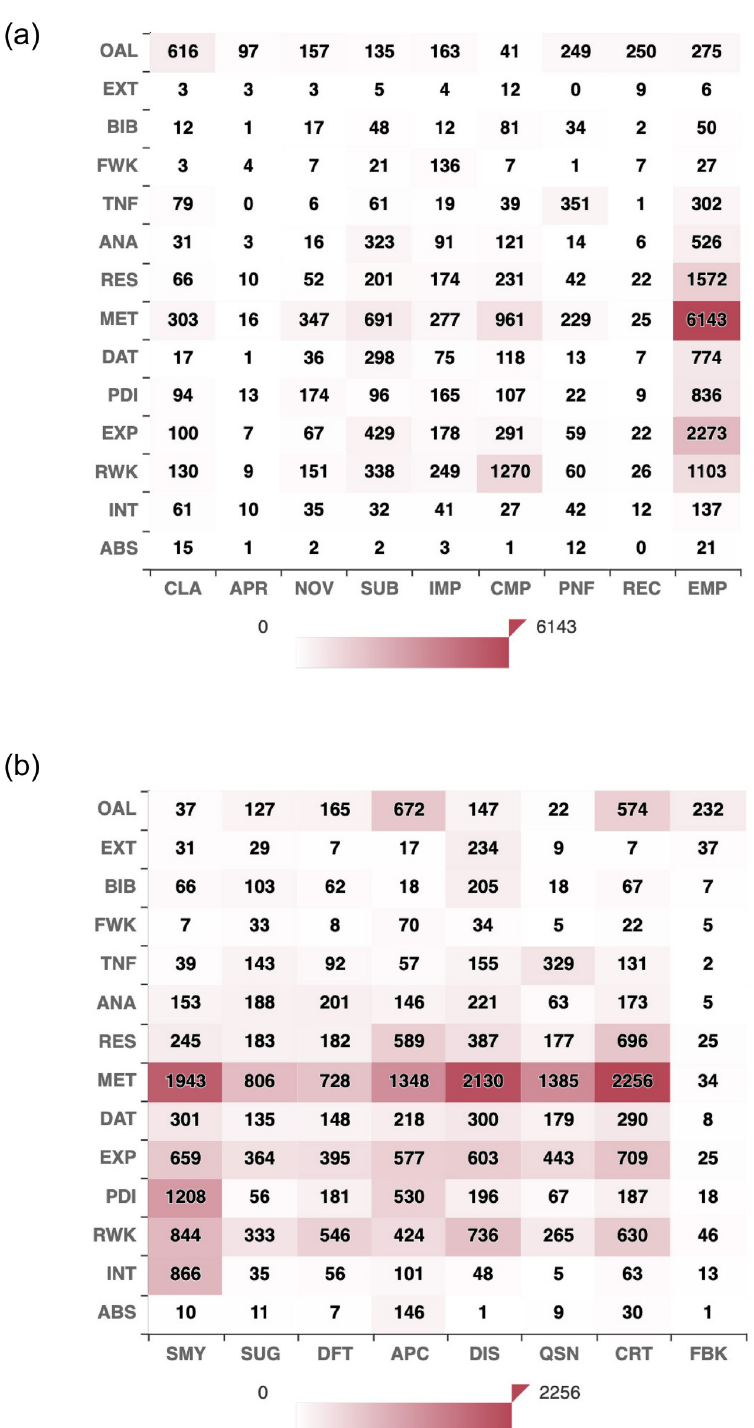
Fig 3. Heatmaps showing the label co-occurrence between two layers highlighting inter-dependency between the layers. (a) Layer 1 vs Layer 2. (b) Layer 1 vs Layer 3.